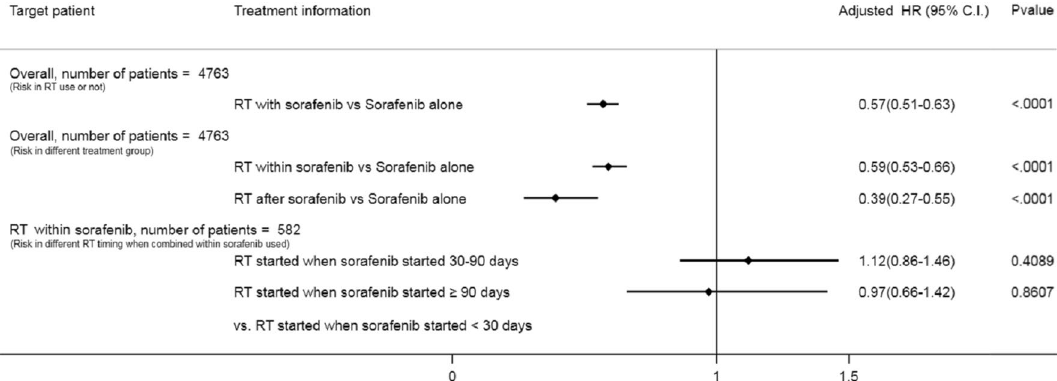
Figure 2. Risk of 1-year mortality of advanced hepatocellular carcinoma patients receiving sorafenib between radiotherapy (RT) use and different